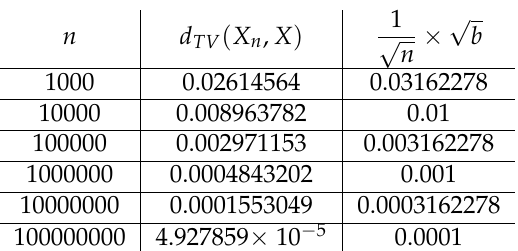
Table 2. Numerical values for b = 1 and k =